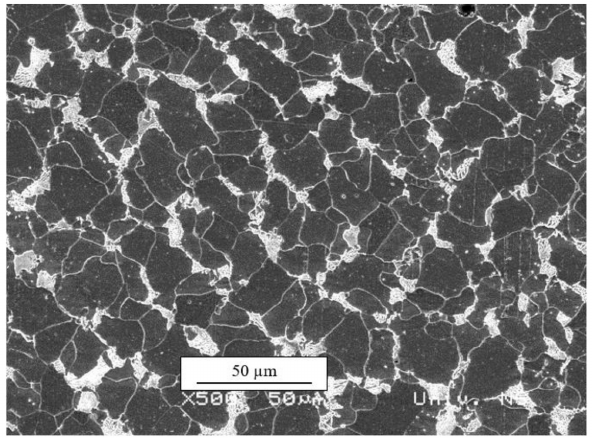
Figure 10. Initial microstructure (SEM, 500 ×